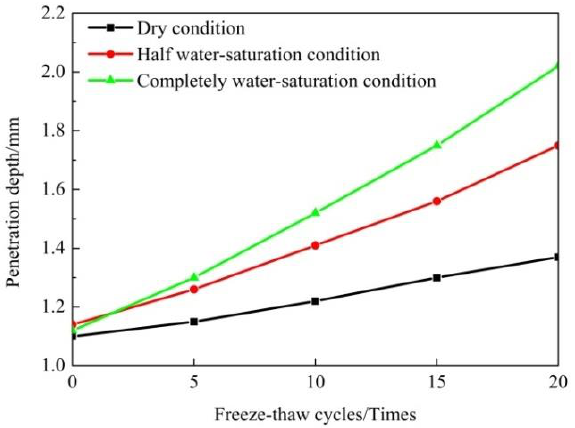
Figure 5. Penetration depth under freeze – thaw cycles with different water saturation